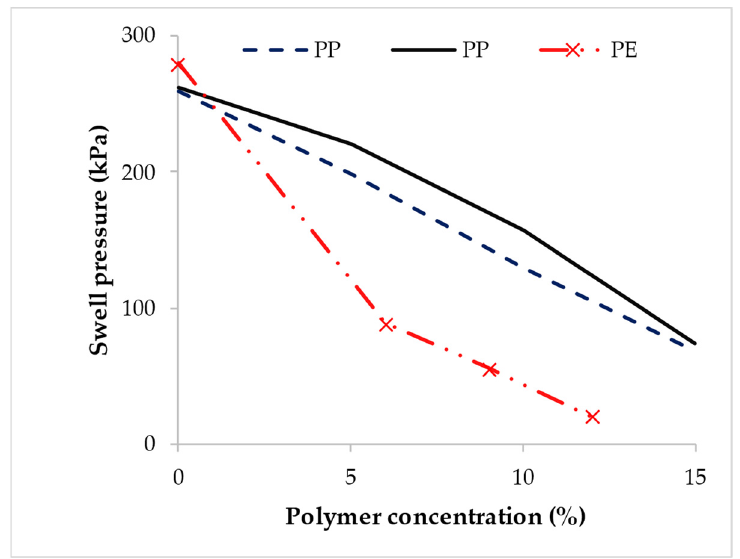
Figure 12. Influence on polymer treatment on the swell pressure of expansive clay (concentration of PP is defined as the % of the dry weight of soil). Note: this figure was created with data obtained from [110,143,171].